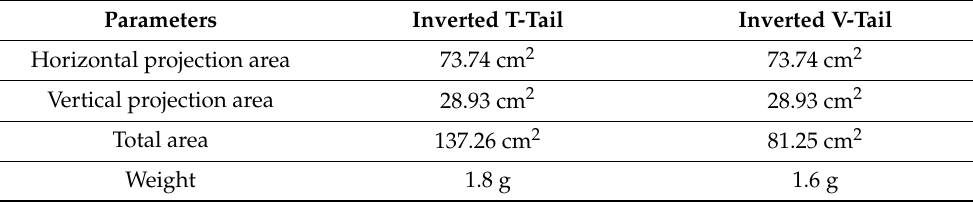
Table 2. Tail design